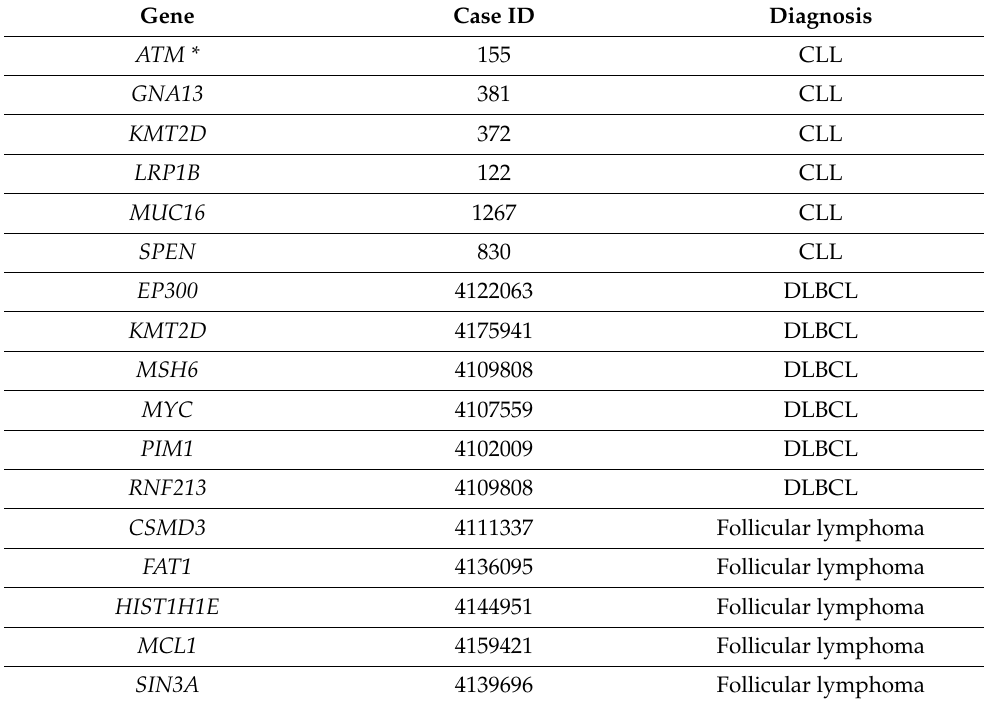
Table 5. Cases of co-occurring somatic mutations and rare germline variants in the same gene. Marked with an asterisk is an event where a rare and likely disruptive germline variant in ATM coexisted with a loss-of-heterozygosity (LOH) at 11q that deleted the wild-type allele. Gene Case ID Diagnosis ATM * 155